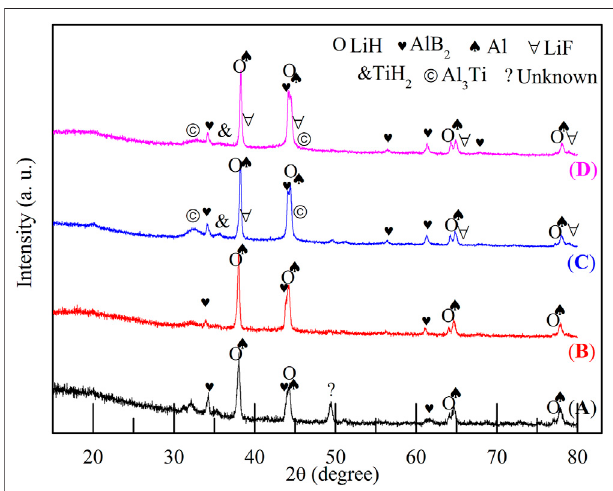
FIGURE 5 | XRD patterns of dehydrogenated 2LiBH 4 – Li 3 AlH 6 samples with different amounts of added TiF 3 : (A) 0 wt%, (B) 5 wt%, (C) 10 wt%, and (D) 15 wt%.